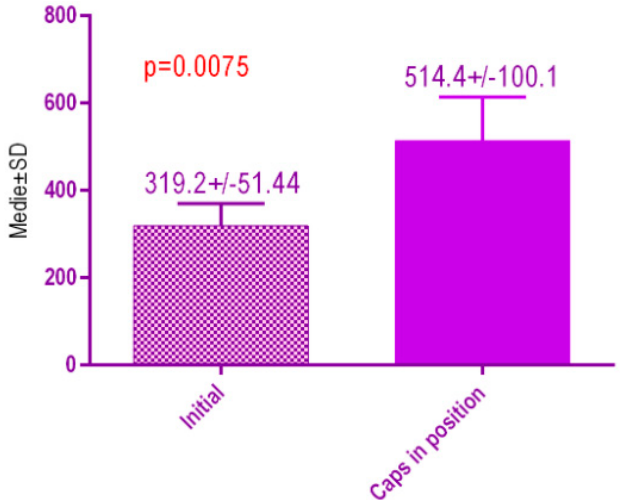
Figure 21. Bone radiodensity in the study groups, patients with orthodontic therapy in medical history, before vs. after treatment with MED healing caps.